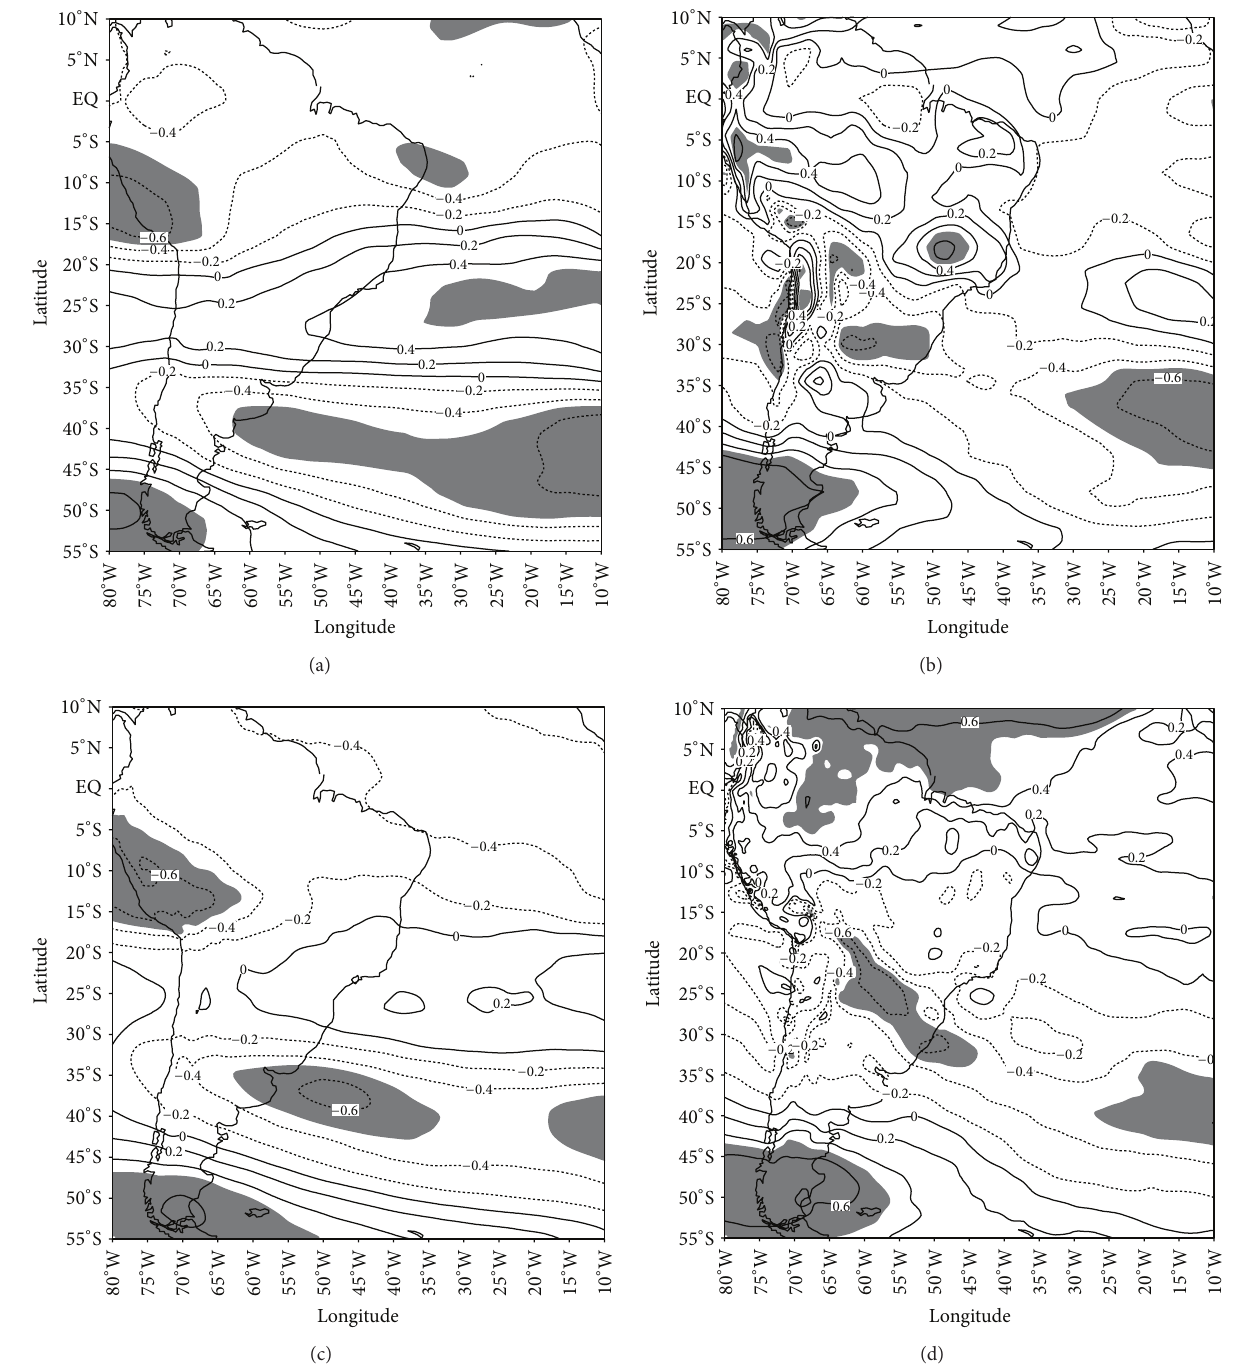
Figure 16: Correlation between the HCSA annual poleward edge time series and the annual mean zonal wind (ms −1 ) in the period 1996–2011 based on the Era-Interim reanalysis at (a) 200 hPa and (b) 850 hPa and RegCM4 simulation at (c) 200 hPa and (d) 850 hPa. Contour intervals are 0.2 and values above 0.5 are shaded and are statistically significant at 95% confidence level. Here, the poleward edge is defined as the latitude where the OLR is equal to 240Wm −2 . For clarity purposes, it should be noted that the HCSA annual poleward edge time series have been multiplied by ( −